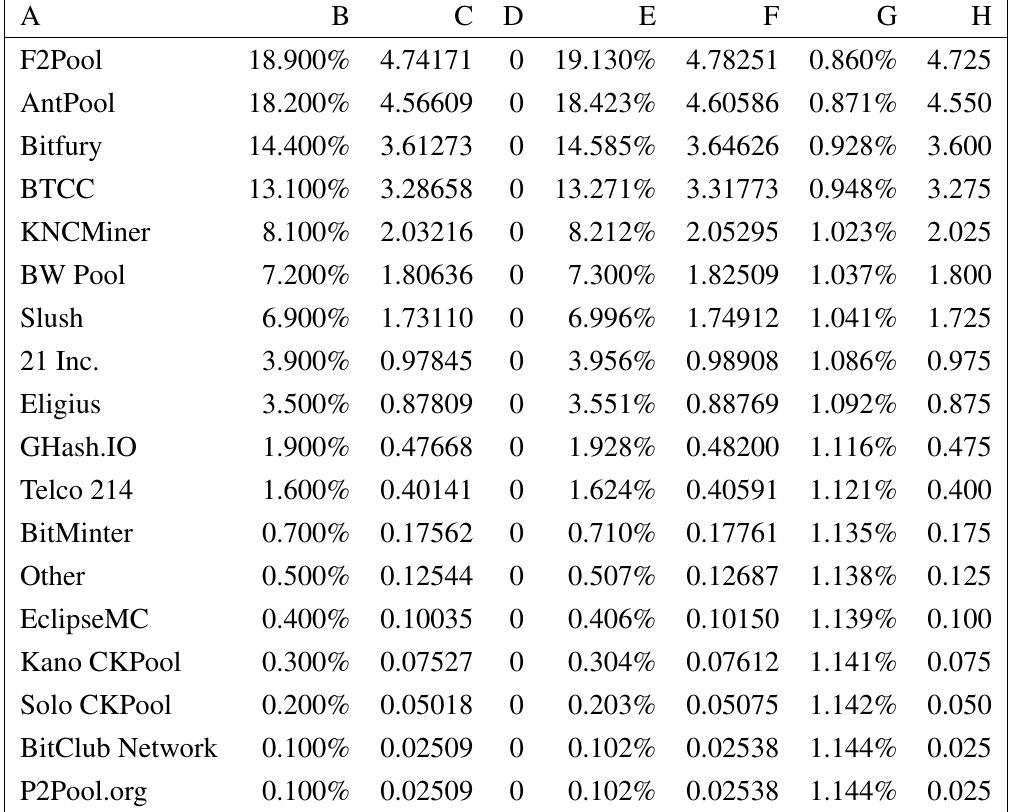
Table 2. A: miner’s name, B: relative computational power, C: expected reward when ∀ i ∈ N , Q i = 884 × 0 . 6 kB , D: optimal number of transaction included by miner i in the current block when ∀ j ∈ N \{ i } , Q j = 884 × 0 . 6 kB (solution to Equation 3), E: probability to be the first miner to find a block reaching consensus when ∀ j ∈ N \{ i } , Q j = × 0 . 6 kB and Q i